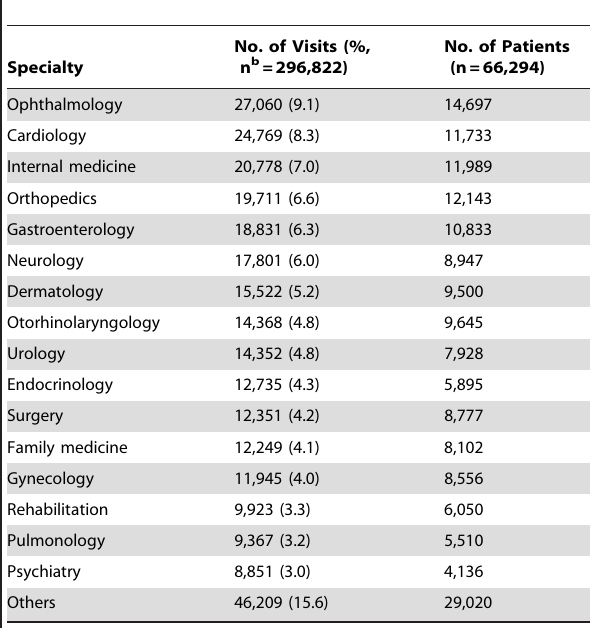
Table 3. Numbers of visits and patients in all one-stop visits a in 2005, stratified by consulted specialty (selected).